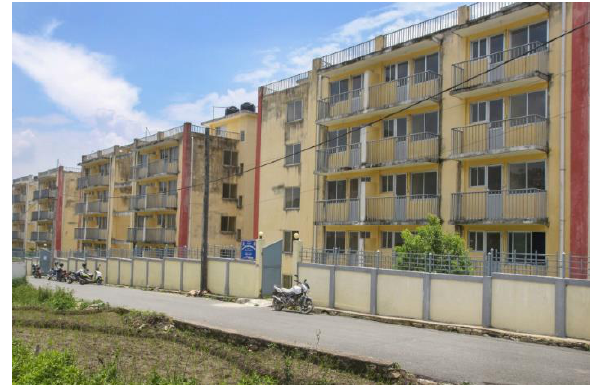
Figure 5. Abandoned Ichangu Narayan Housing Project for urban poor.